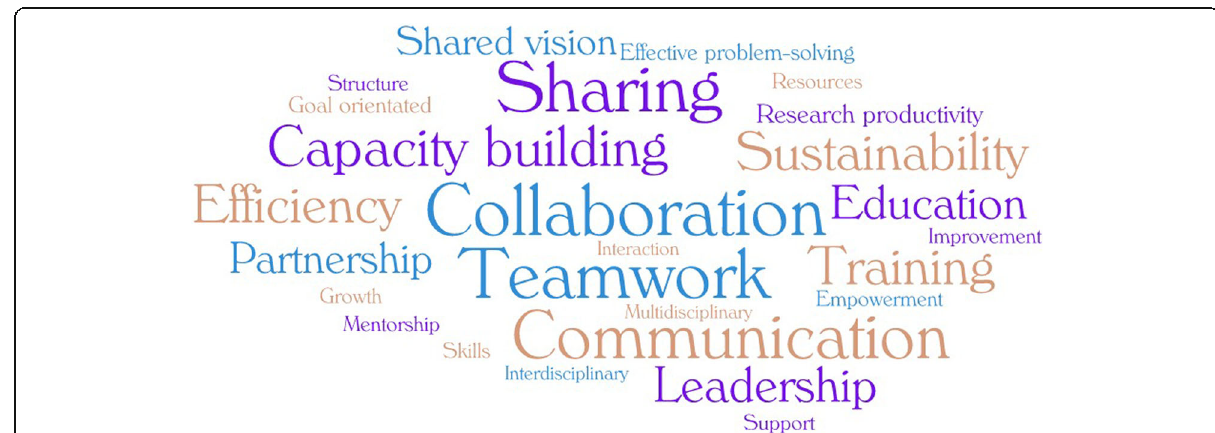
Fig. 2 Word clouds of some key attributes of clinical research